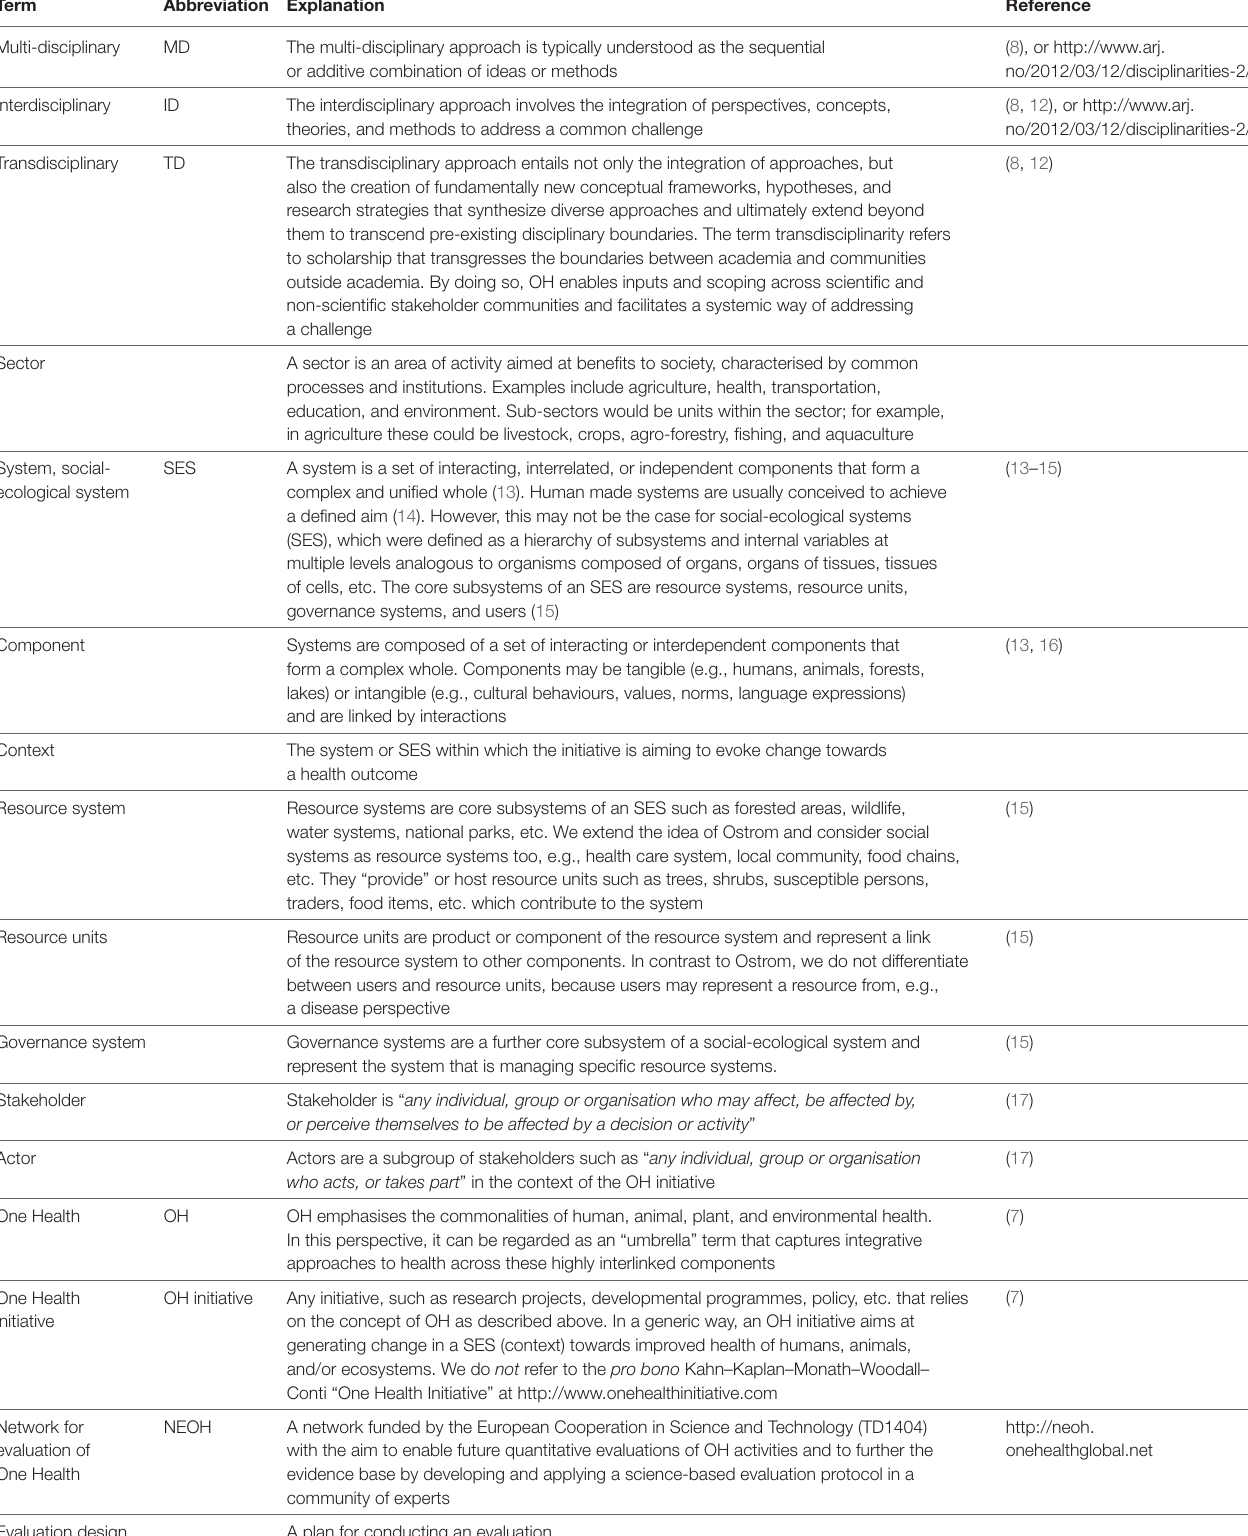
tAbLe 1 | Glossary of terms and abbreviations used in this